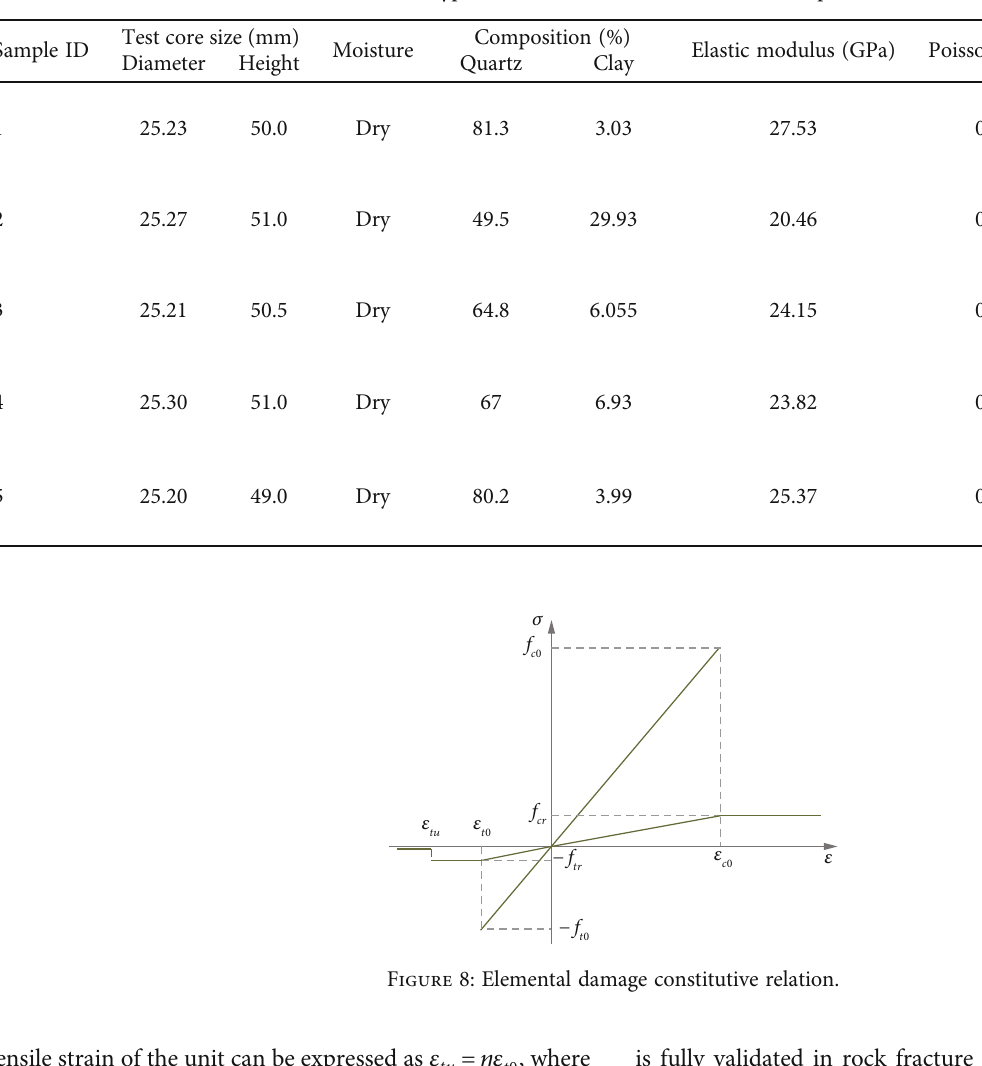
Table 1: Five types of dimensions and rock mechanical